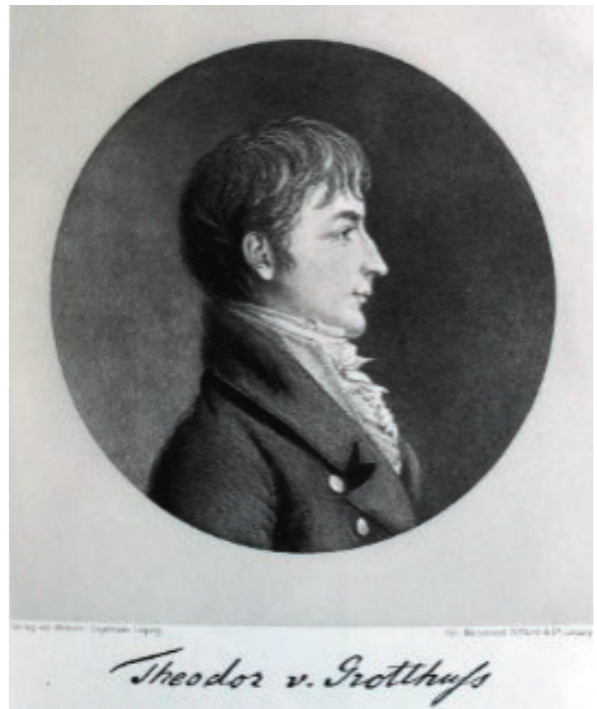
Figure 4. Portrait of baron Christian Johann Dietrich Theodor von Grotthuß (C. J. Théodore de Grotthuss). Photogravure by Meisen- bach and Riffart & Co. in Leipzig, produced prior to 1894,